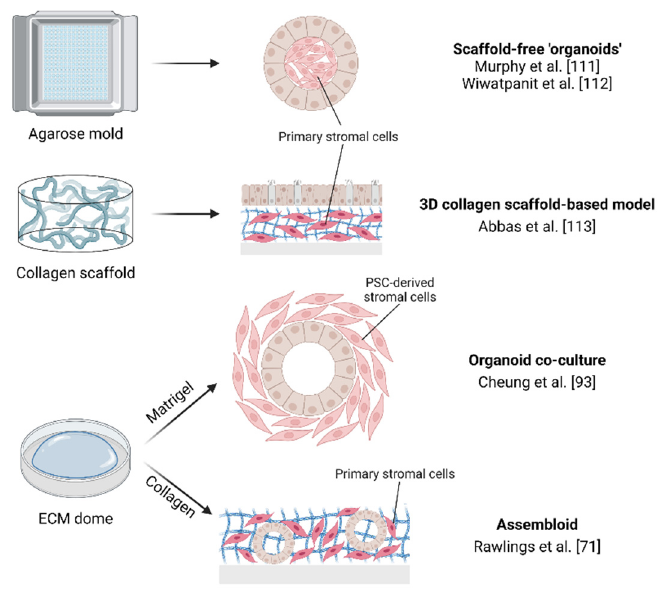
Figure 3. Endometrium composite models [1–5]. Created with BioRender.